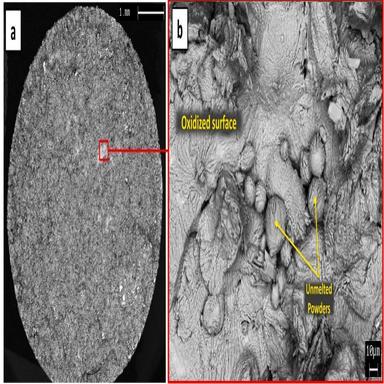
(a) SEM image of "600◦C_AM.asb.V" specimen fracture surface; (b) magnification on oxidized surface with unmelted particles.